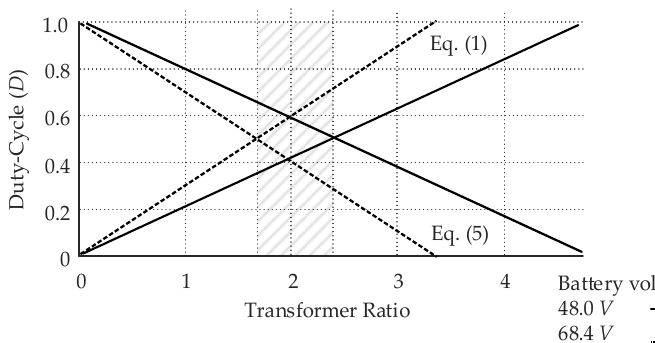
(b) Figure 5. Theoretical waveforms of the converter operating in: ( a ) Step-down mode during the batteries’ charge, ( b ) step-up mode during the batteries’ discharge. 2.4. Converter Design